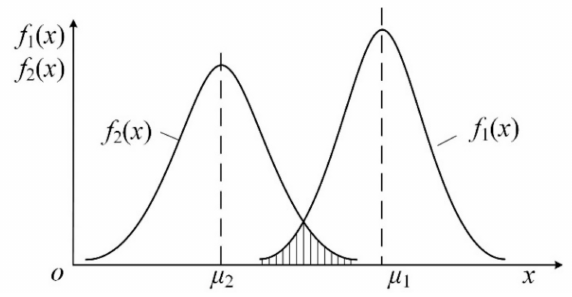
Figure 1. The stress–strength interference